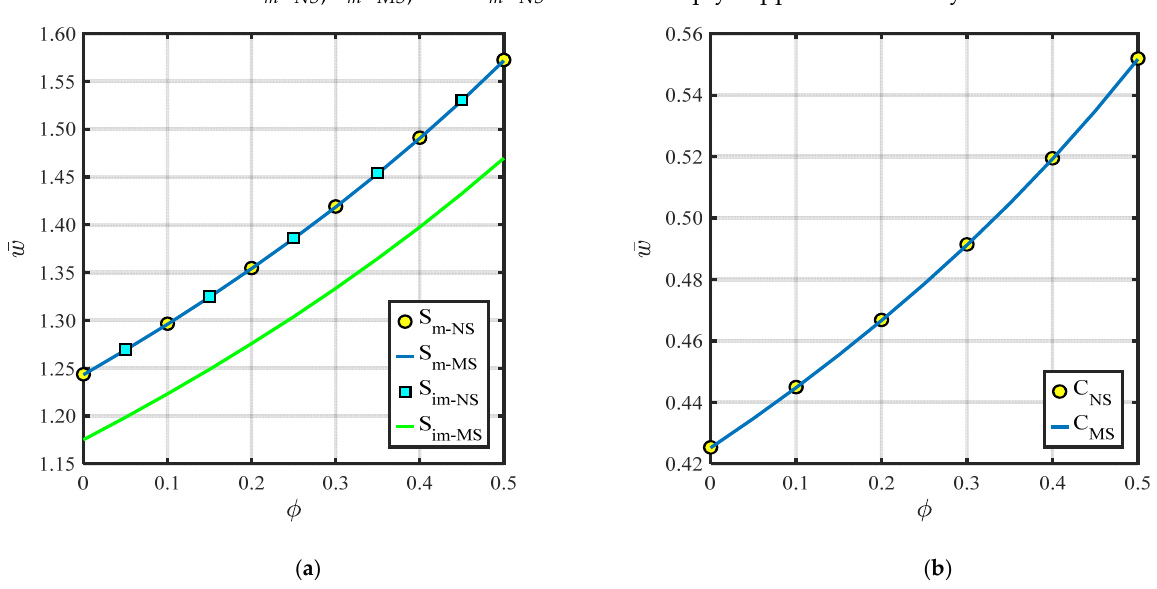
Figure 9. Non-dimensional maximum deflection (cid:4672)𝑤(cid:3365) = 𝑤 (cid:3040)(cid:3028)(cid:3051) (cid:2869)(cid:2868)(cid:2868)(cid:3006) (cid:3278) (cid:3035) load at different aspect ratio b / a , ( a / h = 10, n x = n z = 1 ) . ( a ) Simply supported. ( b ) Fully Clamped.